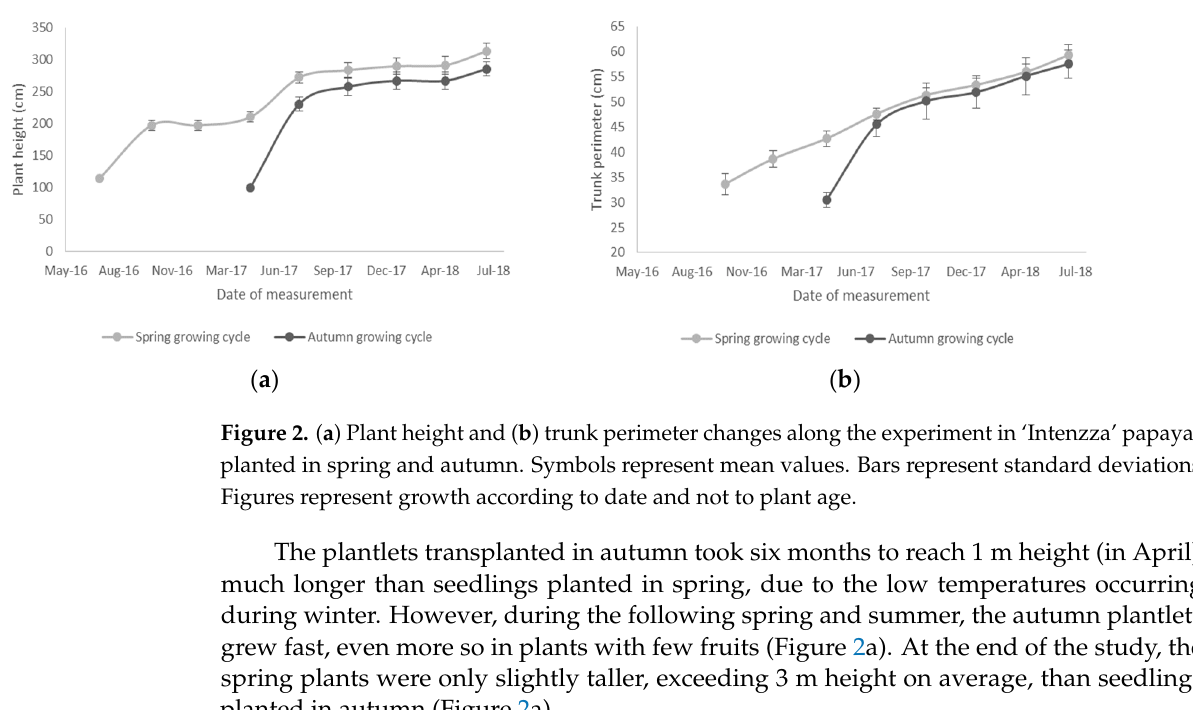
Table 1. Morphological features of ‘Intenzza’ papayas of spring versus autumn planting season.